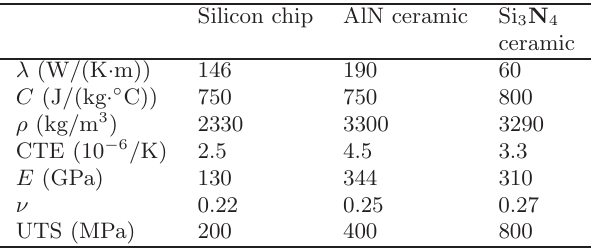
Table 3. Chips and ceramics constitutive laws parameters